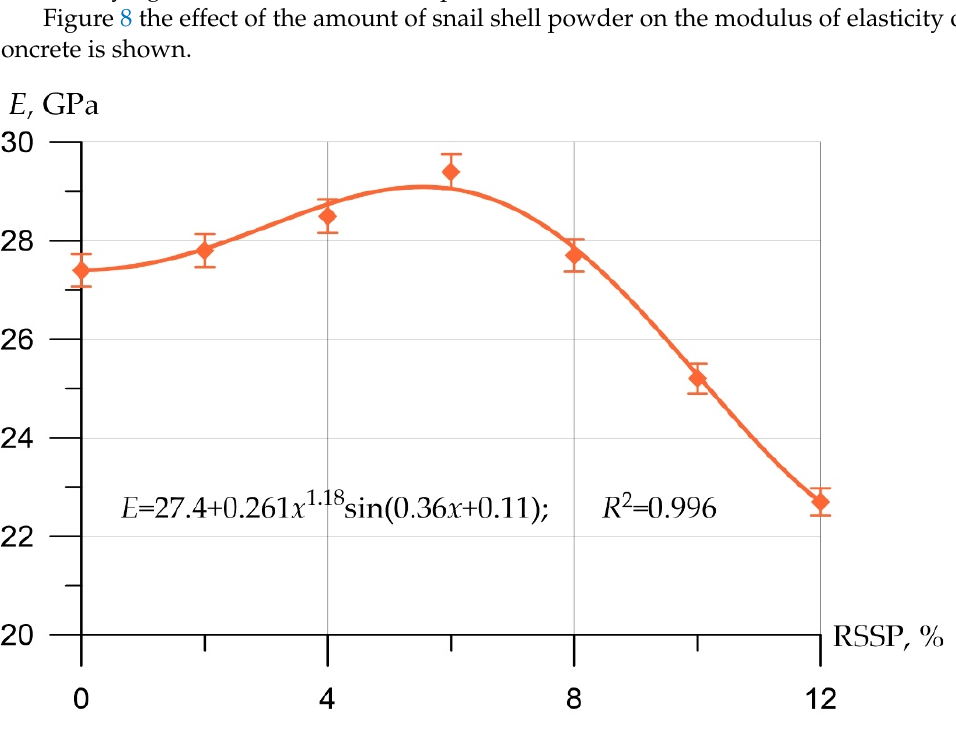
Figure 8. Modulus of elasticity of river snail shell powder concrete. The “dependence of the modulus of elasticity of concrete on the amount of snail shell powder is approximated by a formula with a determination coefficient” of